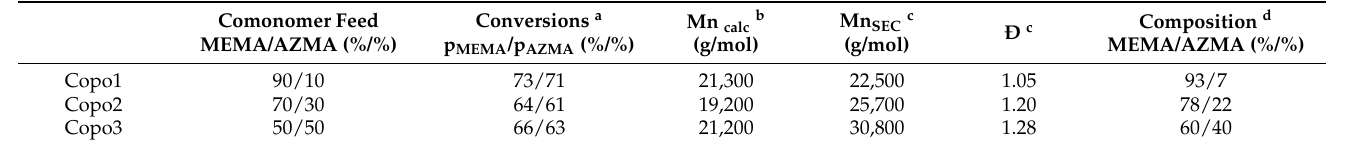
Table 1. Copolymerization of MEMA and AZMA in anhydrous acetone at 50 °C with 5 vol% DPE